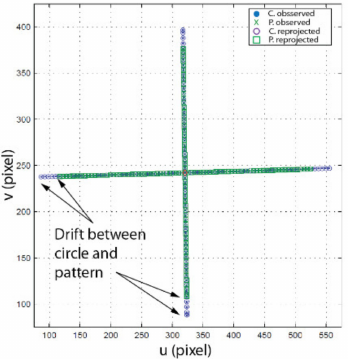
Figure 32. Result for the calibration of a two-axis mechanism showing the observed and reprojected position of the circle and pattern. The drift between the circle and pattern is visible on both